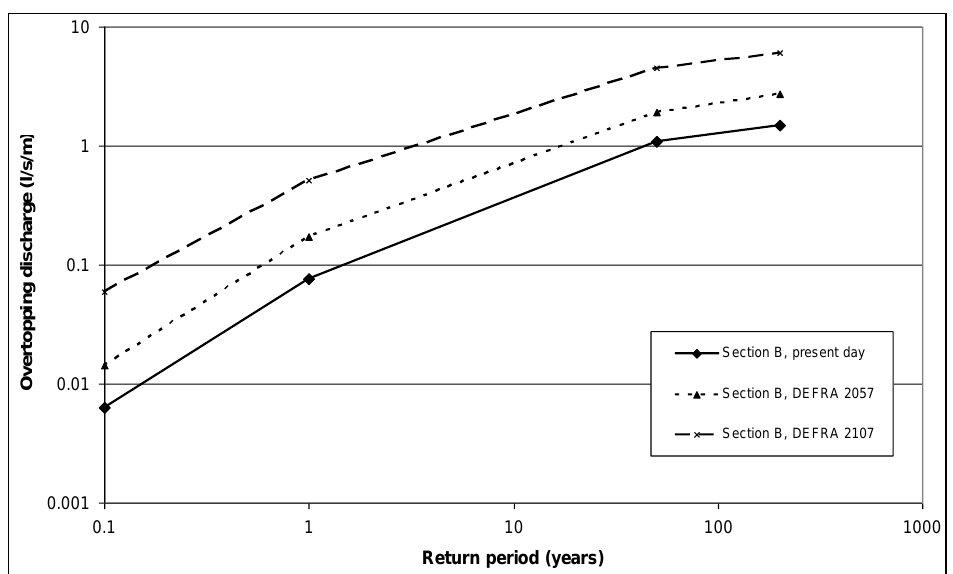
Figure 5. Wave overtopping projections.